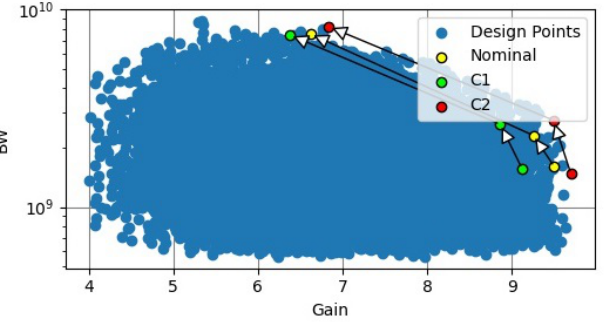
Figure 5. Bandwidth vs. gain design space and optimal design points for the three corners: TT 27 ◦ C (Nominal), FF − 40 ◦ C (C1), and SS 125 ◦ C (C2).